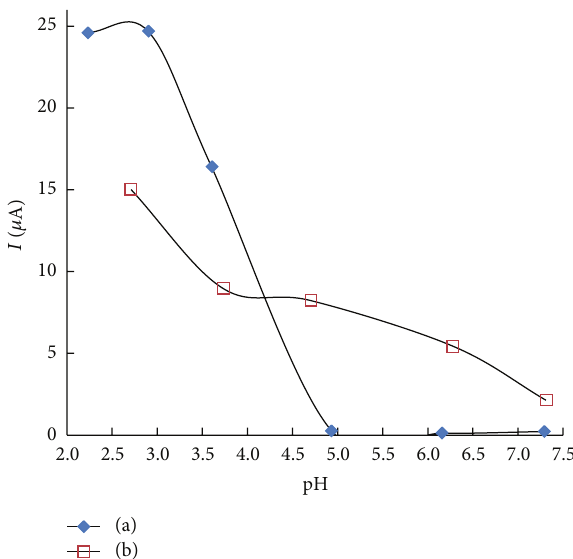
Figure 6: The effect of (a) Pb(II) and (b) Cu(II) preconcentra- tion standards of various pH values for Acetabularia -CPE. The conditions used were one minute of accumulation followed by applying optimum deposition potential and optimum scan rate in 0.1MKNO 3 electrolyte.